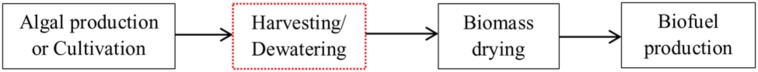
General flow diagram of algae biofuel production phases.